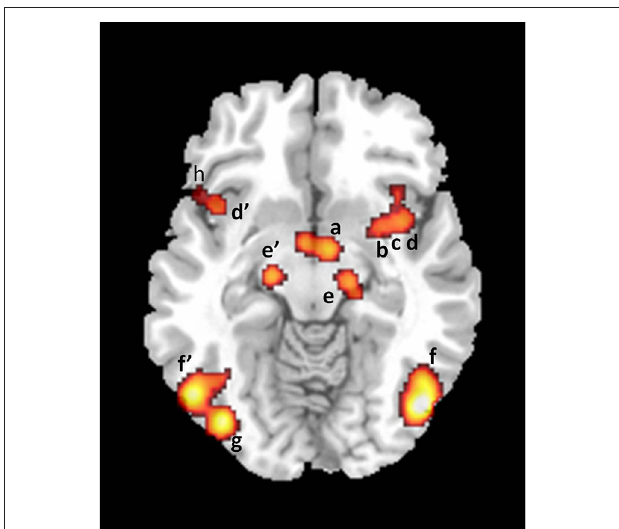
FIGURE 4 | Axial section showing activations found in a meta-analysis of 21 studies of brain responses of heterosexual men to sexual stimuli (unpublished figure from study by Stoléru et al., 2012). Section is located 10 mm below bicommissural plane. a: hypothalamus; b: putamen; c: claustrum; d, d’: insula; e, e’: substantia nigra; f, f’: inferior temporal gyri; g: inferior occipital gyrus; h: inferior frontal gyrus. Right is to the